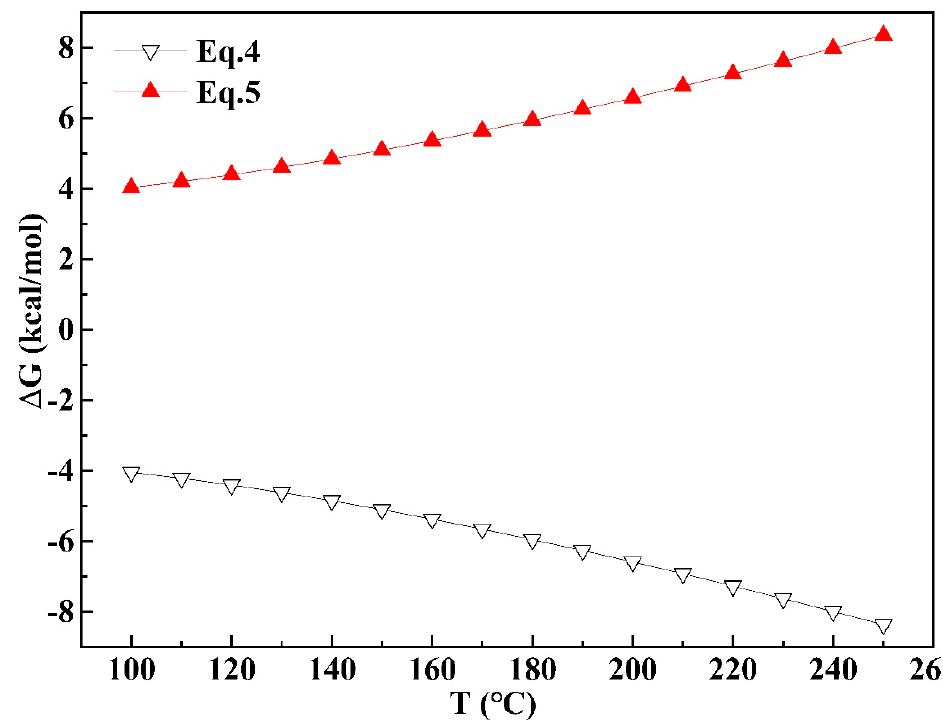
Figure 7. The Δ G θ values of Equations (4) and (5) at different temperatures. Figure 7. The ∆ G θ values of Equations (4) and (5) at different